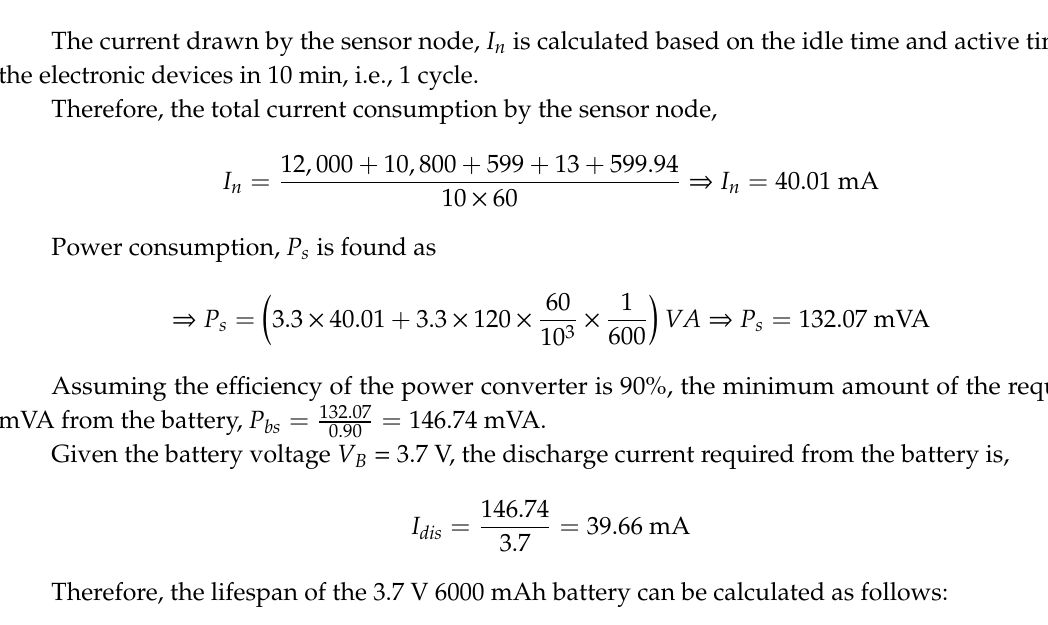
Table 6. Measured current drawn by the electronic devices of the sensor node in one cycle. Current Consumption Current Drawn in One Cycle Name of the Time (mA) (mAsec) Component Arduino Uno MCU 10 min 20 20 × 10 × 60 = 12,000 six PIR sensors 10 min 18 18 × 10 × 60 = 10,800 Env. combo (idle) 9 min 59 s 1 1 × ( 9 × 60 + 59 ) = 599 Env. combo (active) 1 s 13 1 × 13 = 13 LoRa shield(idle) 9 min 59 s 940 ms